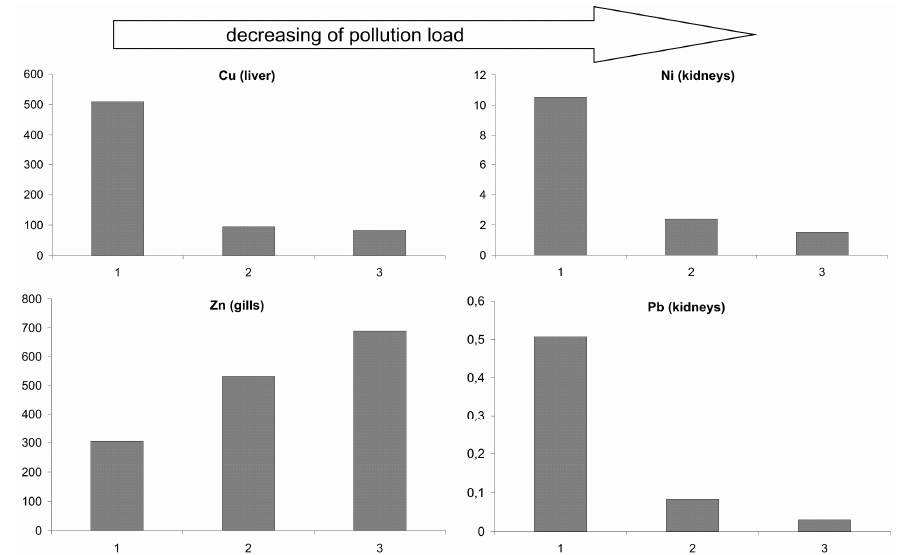
Figure 4. The HM concentration in trout tissues ( µ g / g of dry weight) (1: Kumuzhie; 2: Jokostrovskaya Imandra; 3: Babinskaya Imandra).